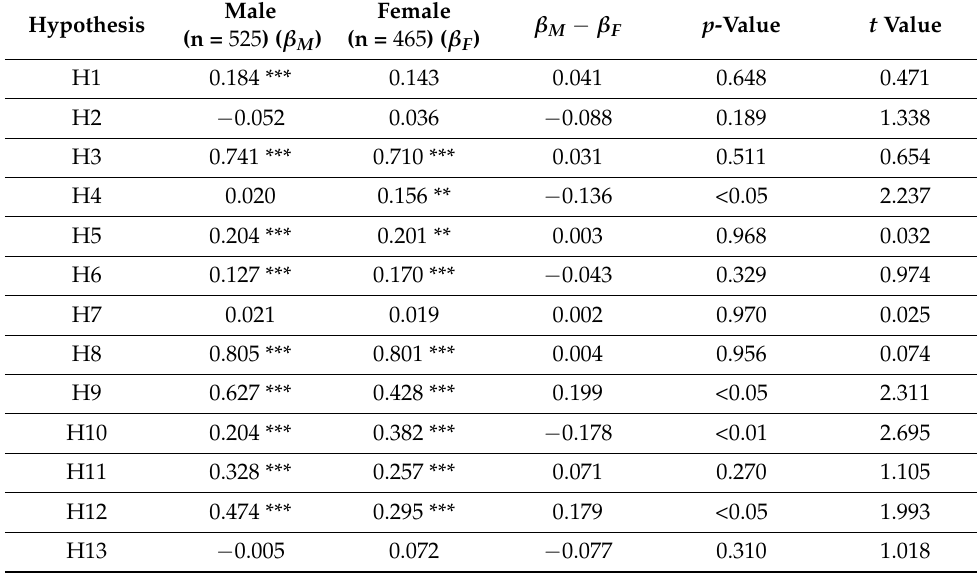
Table 7. Multi-group analysis by